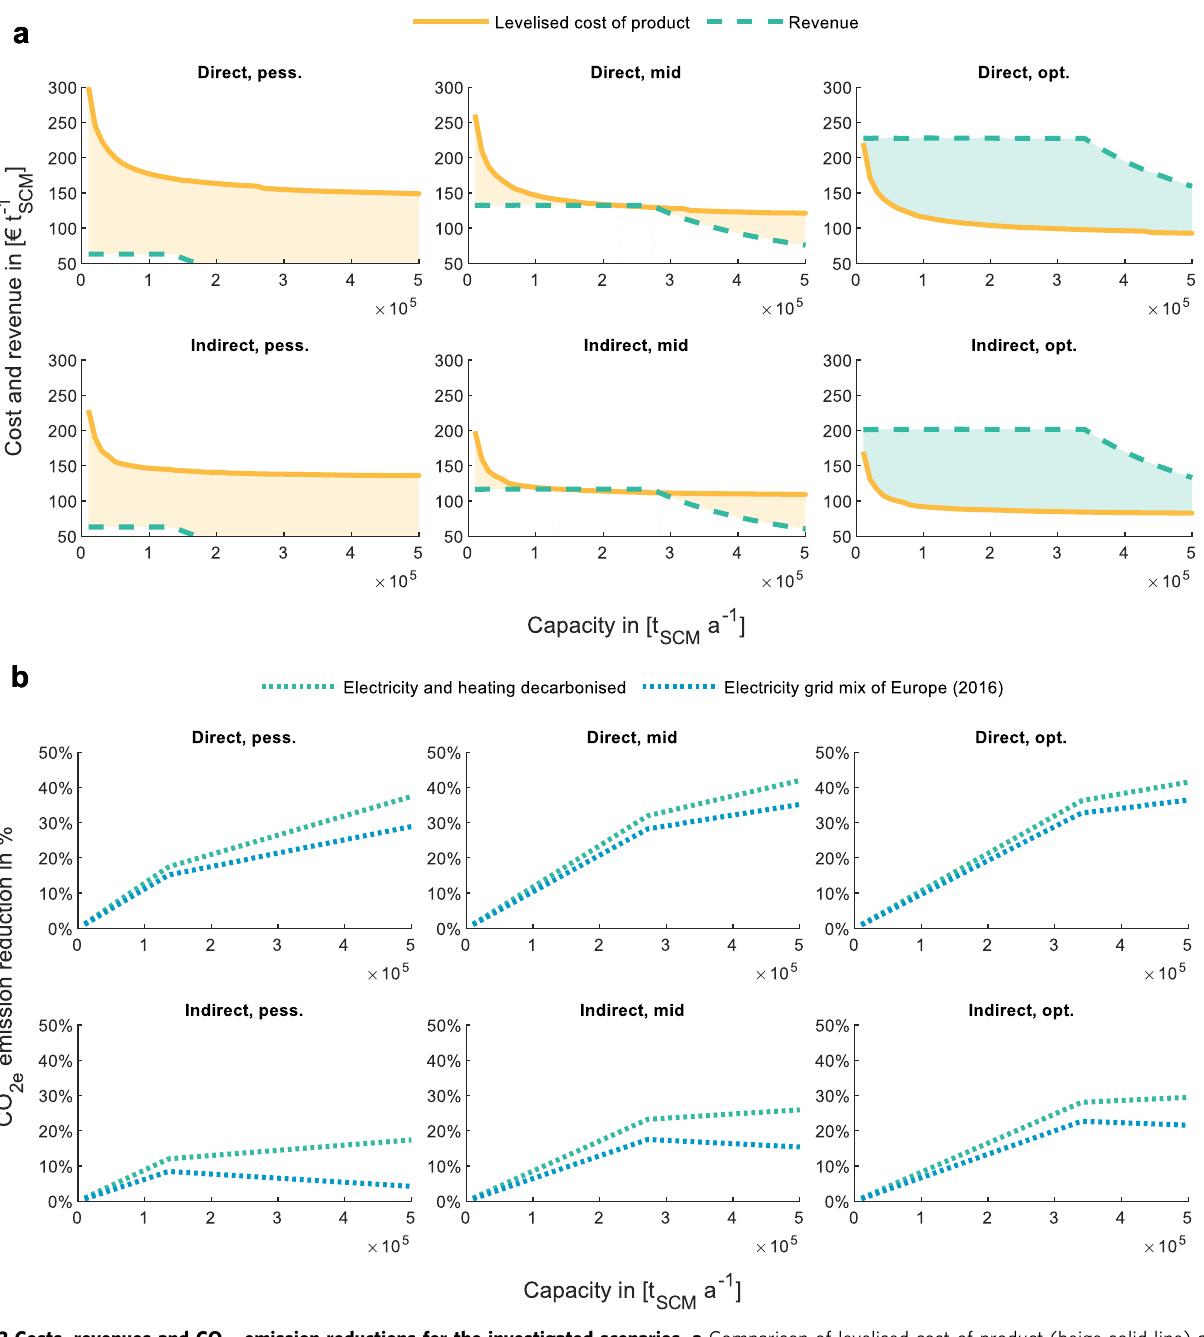
Fig. 2 Costs, revenues and CO 2e emission reductions for the investigated scenarios. a Comparison of levelised cost of product (beige solid line) and revenue (green dashed line), pro fi table areas marked in green, unpro fi table areas marked in beige. b CO 2e emission reduction calculated using two grid emission scenarios — considering electricity grid mix of Europe (2016) (blue dotted line) and considering decarbonisation of electricity and heating (green dotted line). a , b Assumptions for the calculations are provided in Supplementary Tables 3 – 13, additional results shown in Supplementary Figs. 5 – 7. b Note, to calculate CO 2e emission reductions in the decarbonised scenario, background emissions coming from production of feedstocks have not been